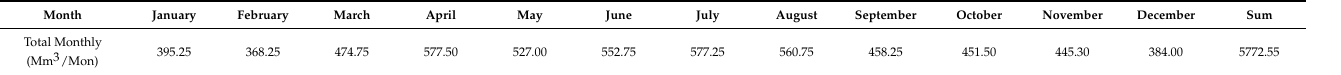
Table 1. Monthly discharge of surface water available in the study area (MWRI)